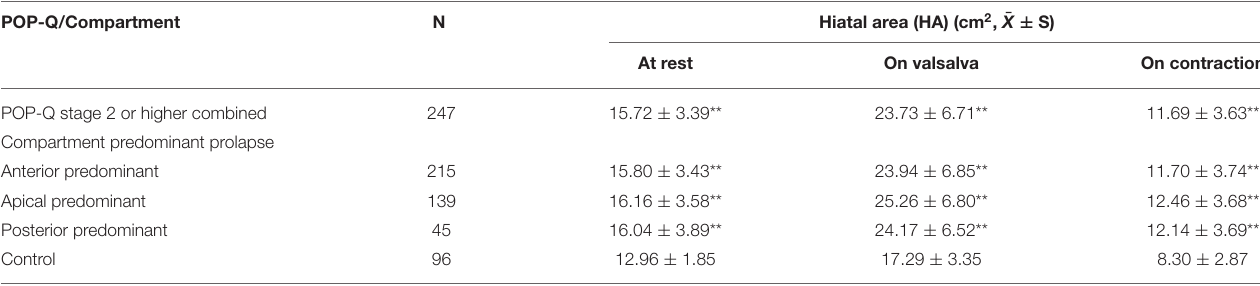
TABLE 3 | Comparison of levator hiatus area between women with and without compartment predominant prolapse (International Continence Society Pelvic Organ Prolapse Quantification (POP-Q), stage 2–3) at rest, maximal contraction, and under Valsalva maneuver.